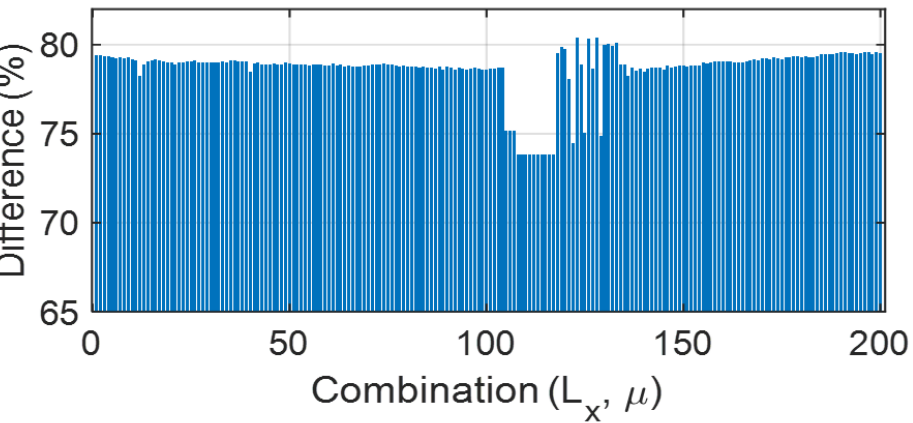
Figure 13. Comparison of 200 sequences generated using different values of µ with the sequence generated with µ = 3.6. For all sequences, L 0 was the same; that is, it was